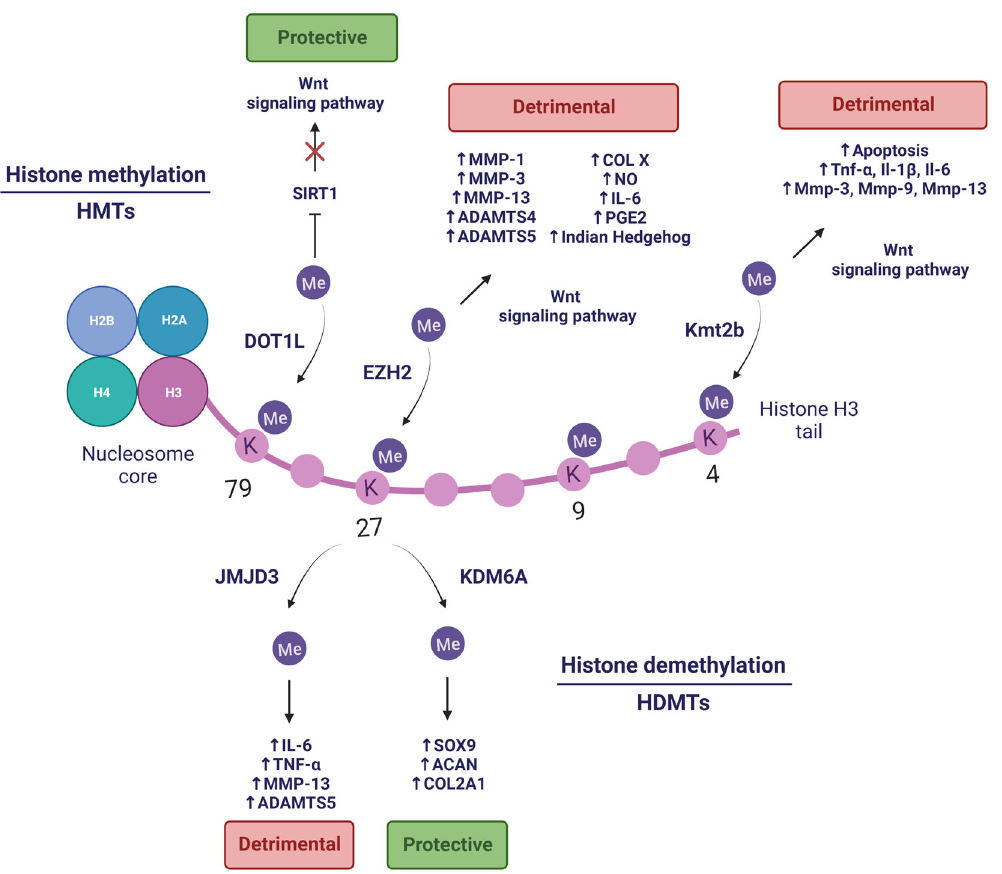
Figure 3. Histone methylation and demethylation in OA. Created with BioRender.com, accessed on 14 January 2023. 14 January